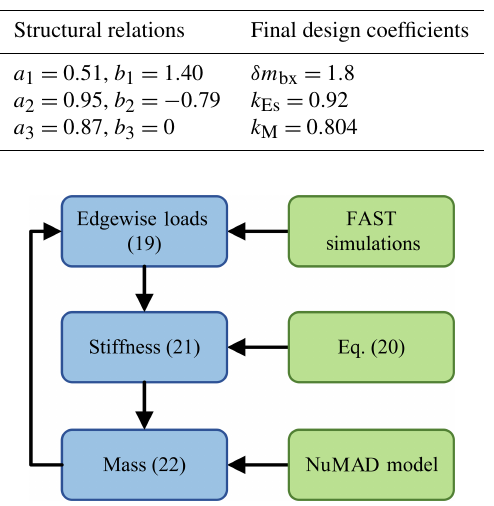
Table 4. Blade structural coefficients for the SUMR-13B blade de- termined using the relationships described in Fig. 11.